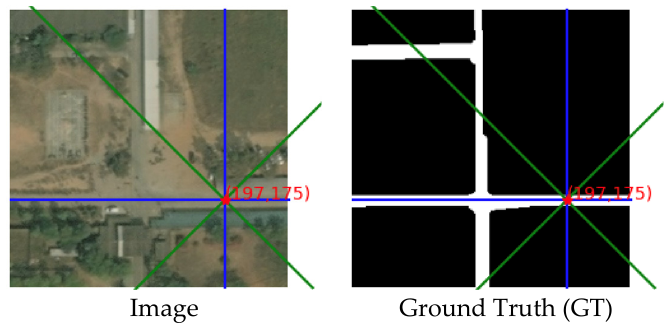
Figure 19. The image and its corresponding ground truth.